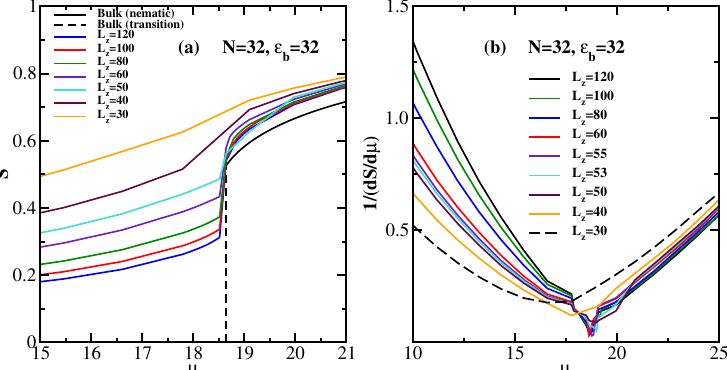
Figure 12. ( a ) DFT results for the nematic order parameter S as a function of the dimensionless chemical potential µ for (cid:101) b = 32, N = 32 and several choices of L z , as indicated. The bulk behavior is included (the vertical broken line indicates the transition in the bulk); ( b ) Inverse response function [ dS ( µ ) / d µ ] − 1 plotted vs. µ for the same case as (a). Reproduced from [45] with the permission of